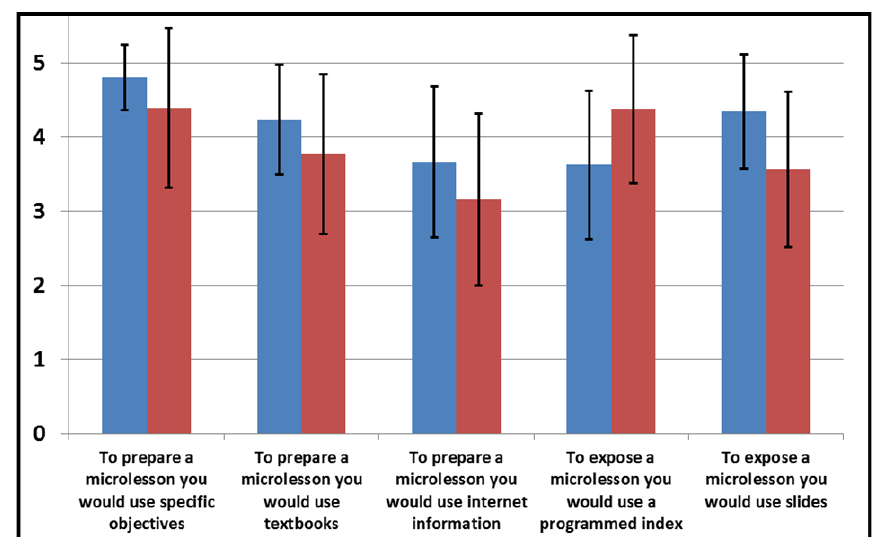
Figure 1. Items that showed statistically significant differences for the comparison of Q1 (before the microlesson) vs. Q2 (after the microlesson) responses. Responses corresponding to Q1 are shown in blue and Q2 responses are in red. Black bars represent standard